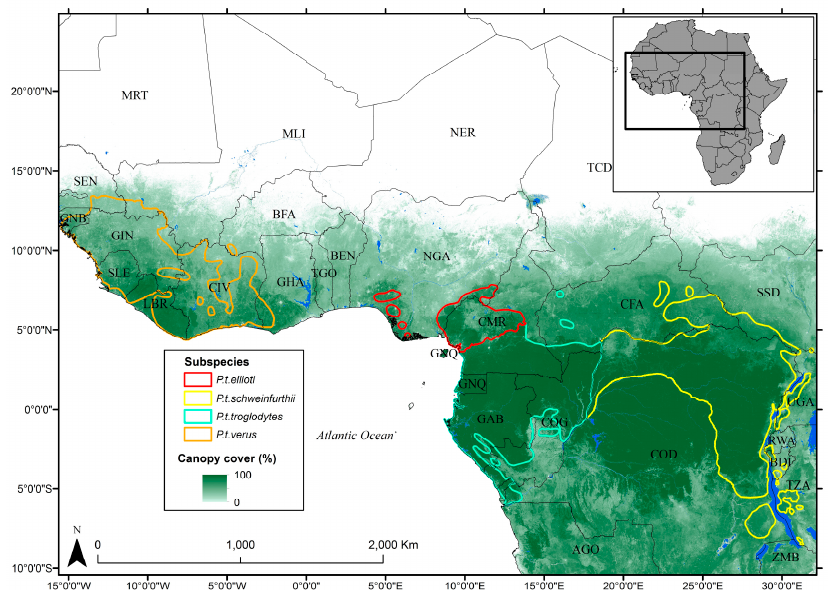
Figure 1. Overview of study area with the International Union for the Conservation of Nature (IUCN) Red List ranges of the four chimpanzee sub-species overlaid on top of a map of percent canopy cover from [28].